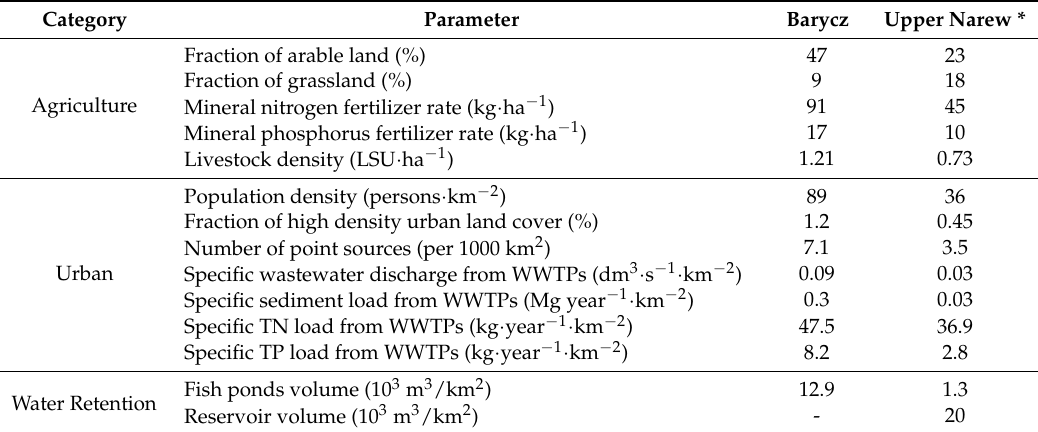
Table 2. Comparison of selected human pressure characteristics of the Upper Narew and the Barycz catchment (sources: